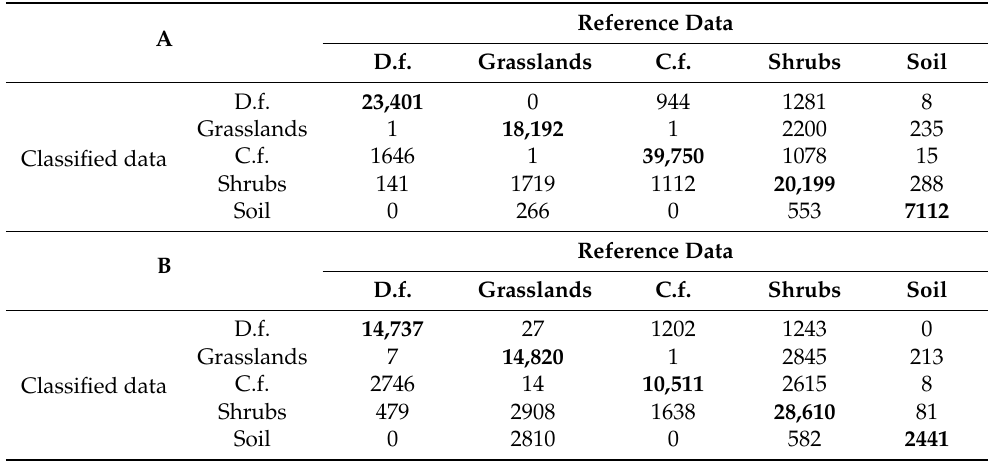
Table 6. Confusion matrix for A and B area for each class (RF and AISA_MNF+CHM+INDICES data set). Explanation: D.f.–Deciduous forest, C.f.–Coniferous forest.